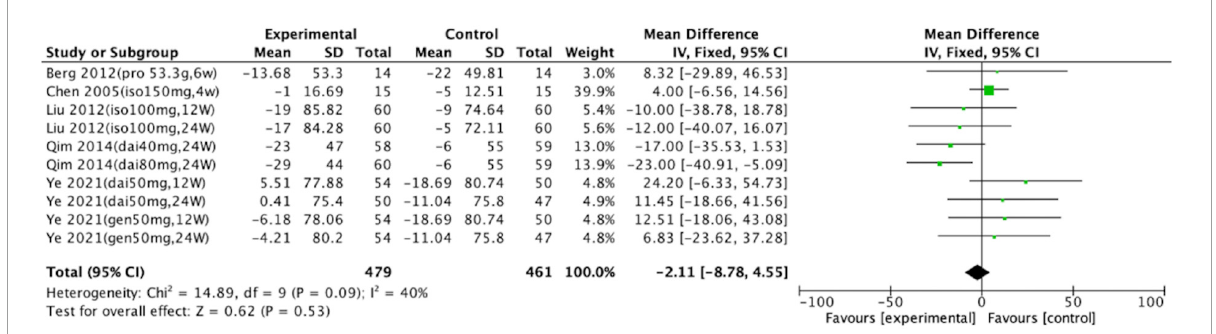
FIGURE2 Forest plot of mean change in uric acid concentration after intervention with soy protein and soy isoflavones (SD, standard deviation; CI, confidence interval; IV, inverse variance; µ mol/L).